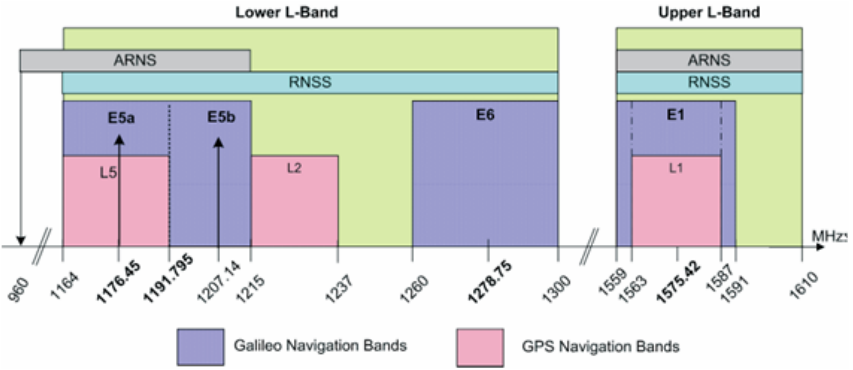
Figure 1. Galileo Frequency Plan [2]. Table 1. The Galileo signal technical characteristics in different